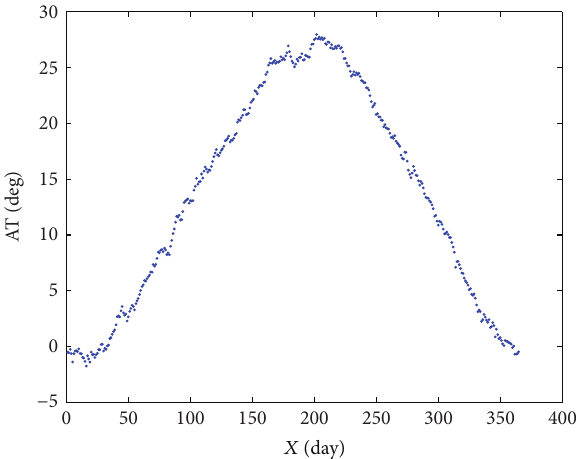
small 𝑝 -value of the test statistic, we may conclude that the heteroscedasticity of the model error is significant over the time that ranges from January 1 to December